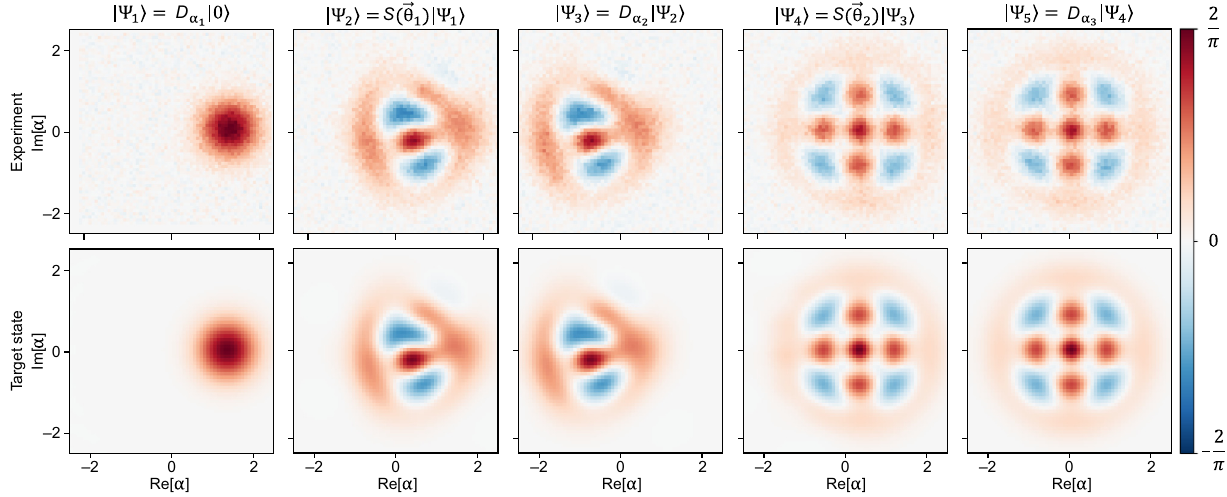
√ 2. Top: experimental data. Bottom: